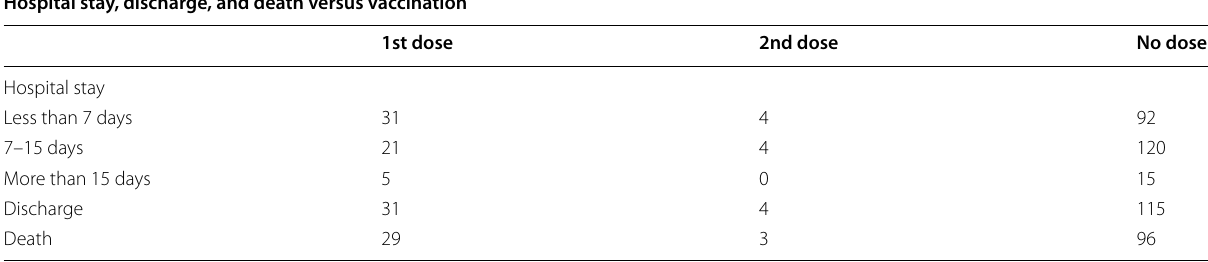
Chi-square test statistics ( p value): 19.608 (0.003) Table 4 Correlation between duration of hospital stay, discharge, and mortality of patient with first, second, and no dose of vaccine ( p value <